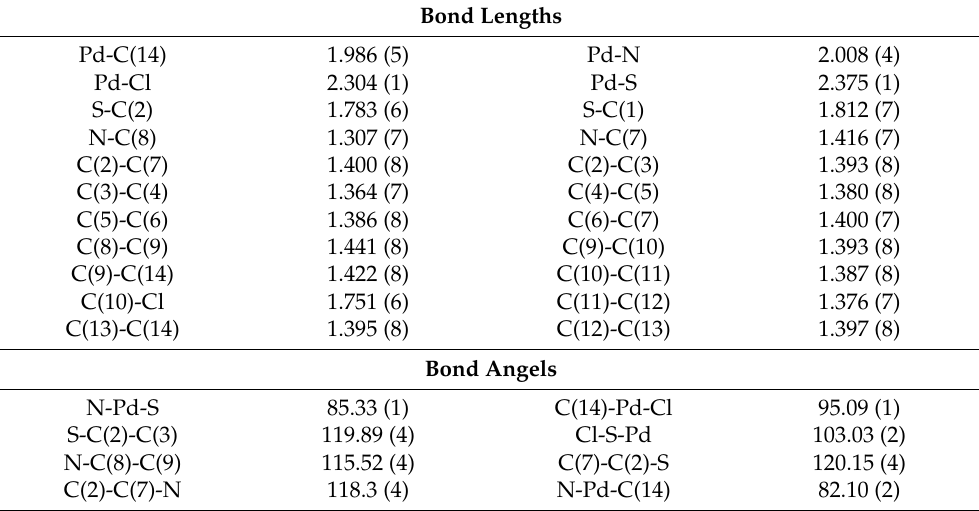
Table 2. Bond length (Å) and bond angles ( o ) for molecular structure 1c